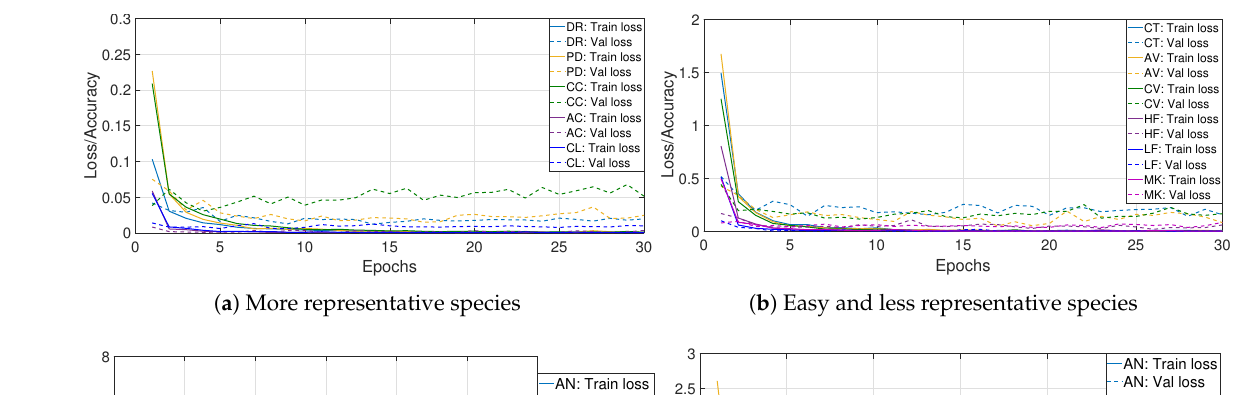
Figure 8. Training/validation loss curves: ( a ) on the FRGT dataset and ( b ) on the LCF-15 dataset.